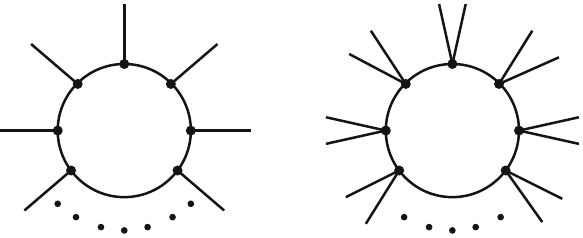
Fig. 1 UV divergent one-loop diagrams with an infinite number of external legs. Derivatives from the vertices σ∂ μ σ∂ μ σ and σ 2 ∂ μ σ∂ μ σ act on the internal